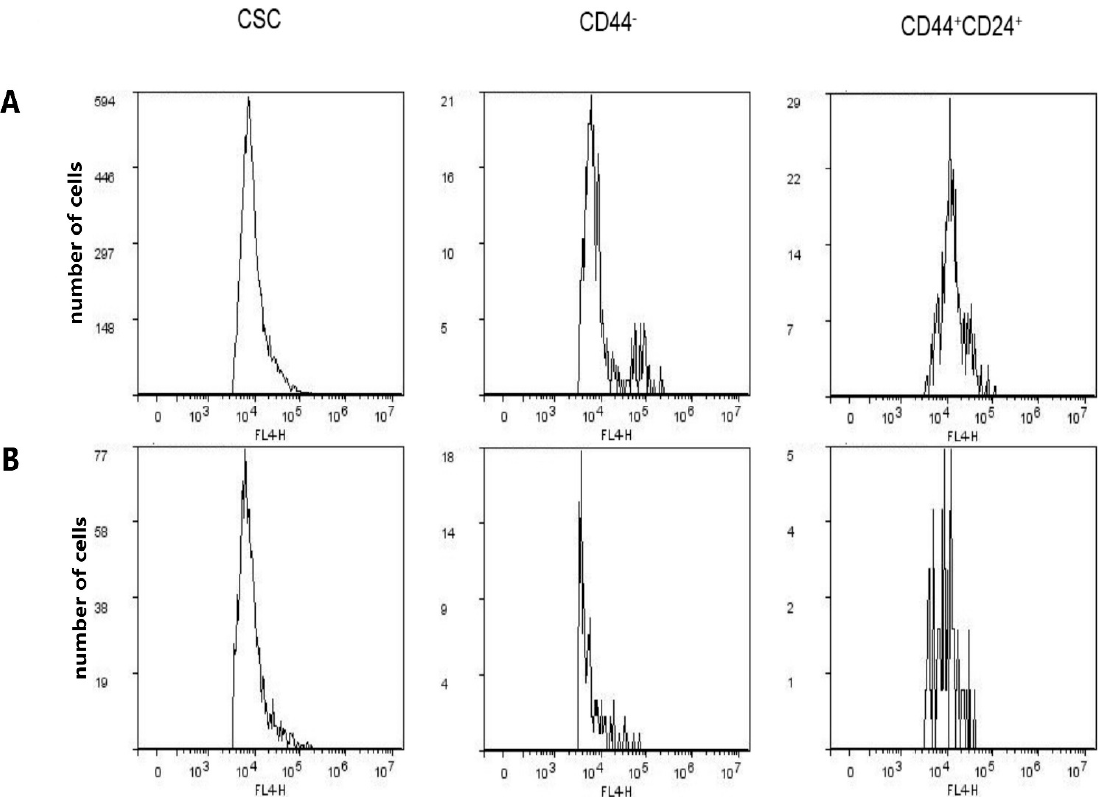
Figure 7. Immunofluorescences of secondary antibody to anti-CD15s in control ( A ) and compound 1 treated cells ( B ). Notes: secondary antibody was conjugated with eFluor 660 fluorochrome. Fluorescences were measured in FL4 channel of flow cytometer for CD15s + CSC, CD15s + CD44 − , and CD15s + CD44 + CD24 + cells. Abbreviations: CSC, cancer stem cells. Table 5. Expression of CD15s in CSC, CD44 − and CD44 + CD24 + subpopulations after treatment with compound 1. CSC CD44 - CD44 + CD24 + Control 1 p- Value